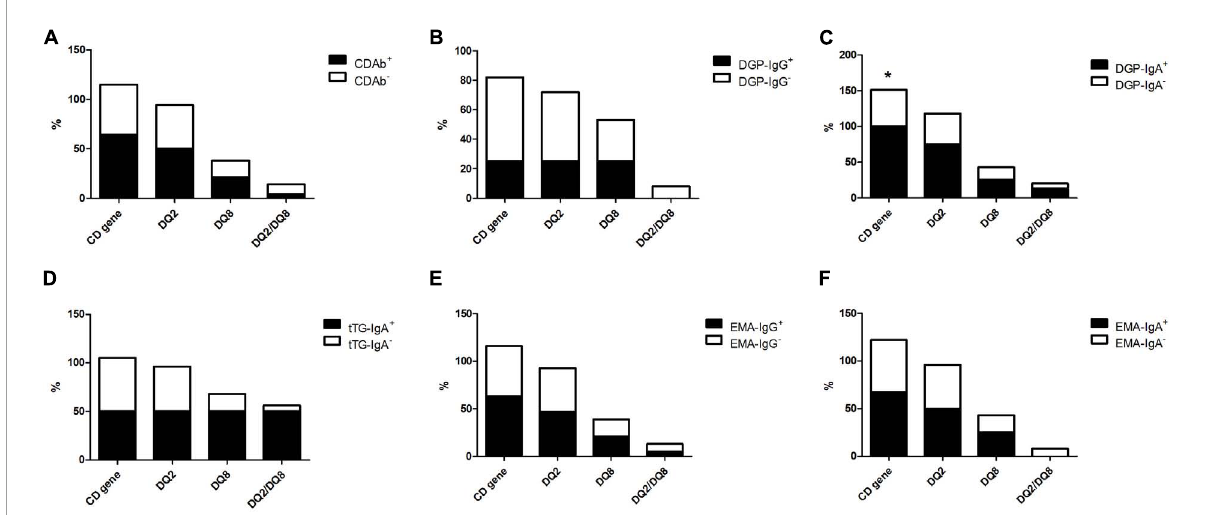
FIGURE2 Profile of the CD-predisposing genes in children with T1D with CDAbs. (* p < 0.05, ** p < 0.01, *** p < 0.001). (A) CDAbs. (B) DGP-IgG. (C) DGP-IgA. (D) tTG-IgA. (E) EMA-IgG. (F) EMA-IgA. Data are expressed as percentages. χ 2 or Fisher’s exact test. CD, celiac disease; CDAbs, celiac disease autoantibodies; T1D, type 1 diabetes; DGP, deaminated gliadin peptide; Ig, immunoglobulin; tTG, tissue transglutaminase; EMA, endomysial